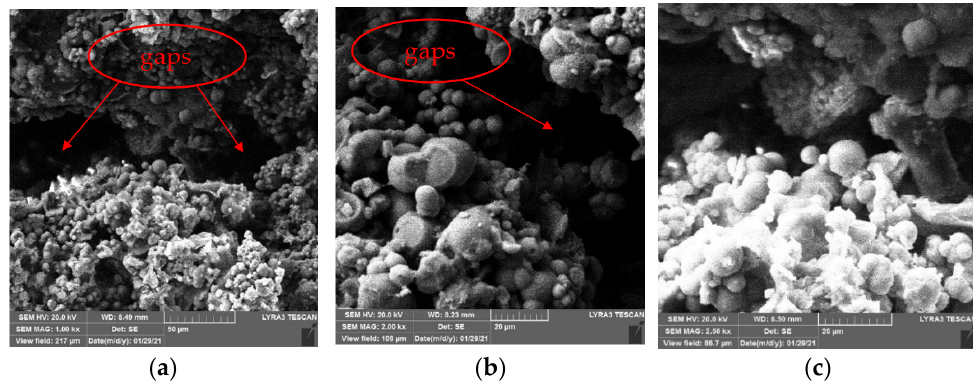
Figure 12. SEM images of specimens repaired by immersion method. ( a ) 1 kx. ( b ) 2 kx. ( c ) 2.5 kx.